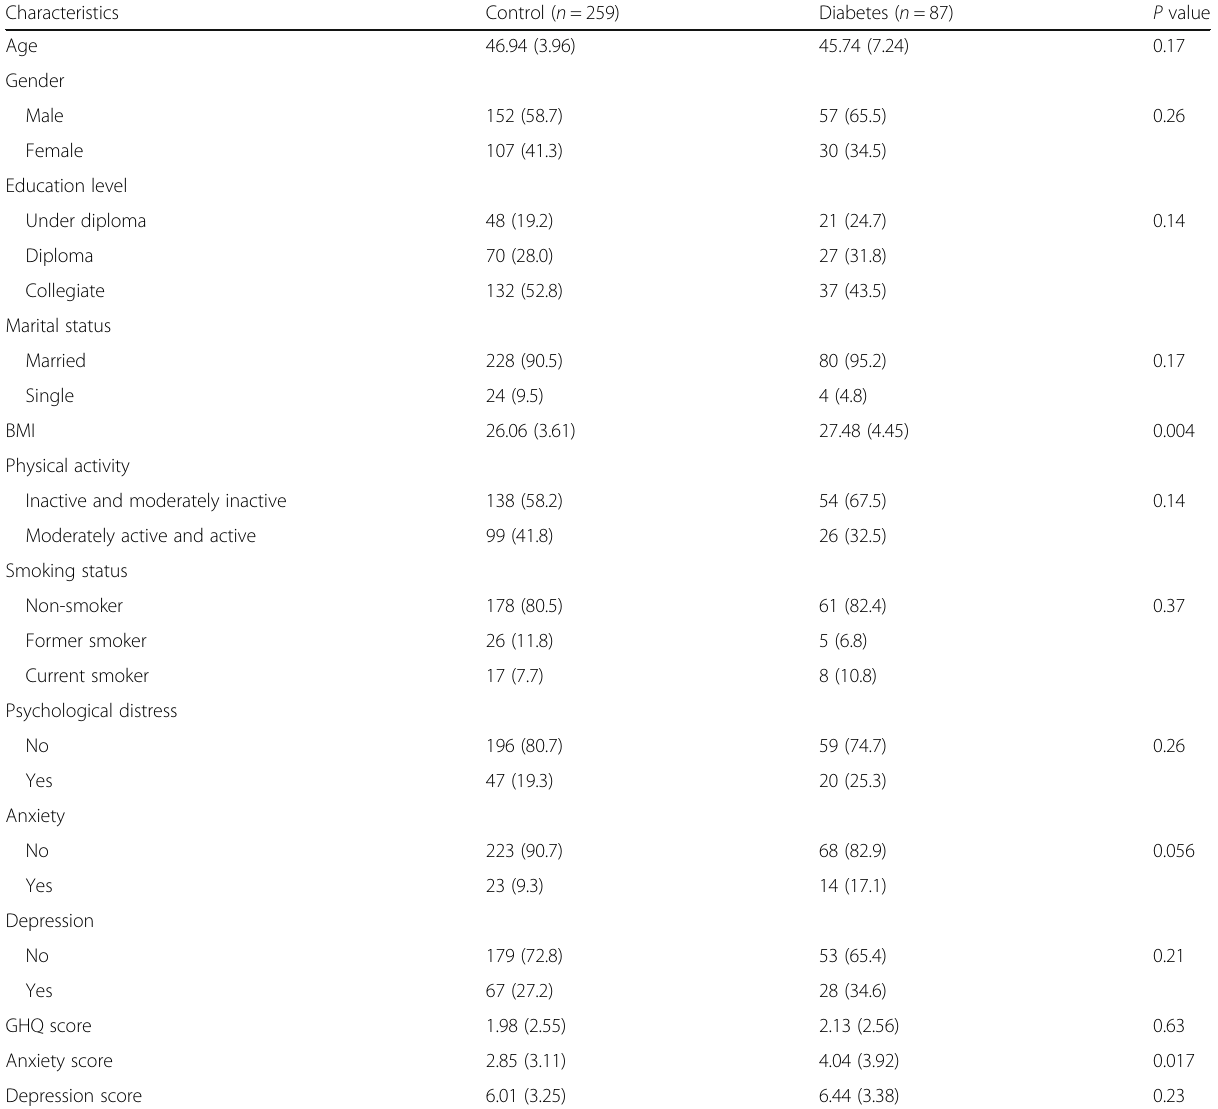
Table 1 Demographic, lifestyle, and psychological characteristics of study participants